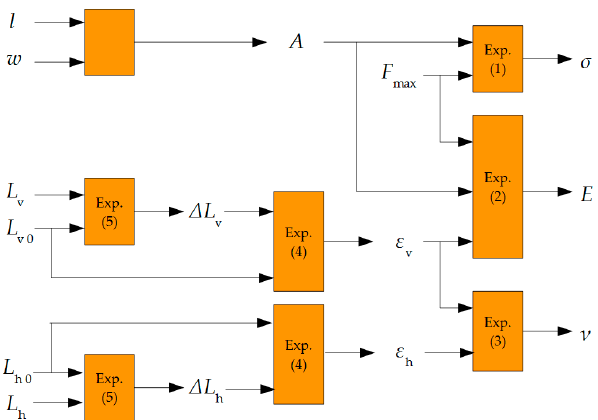
Figure 2. Functional diagram of the quantities and mathematical models related to the compressive mechanical testing of masonry specimens.